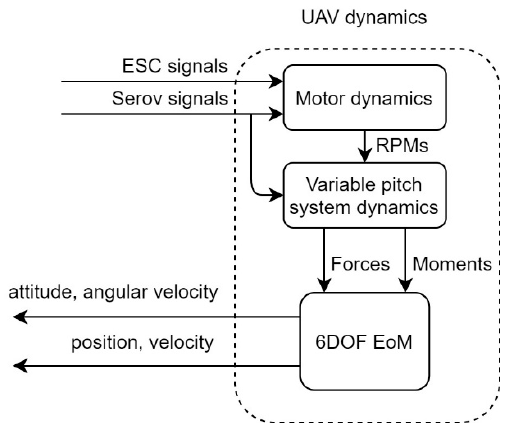
Figure 6. Flow chart of the unmanned aerial vehicle (UAV) dynamics model.